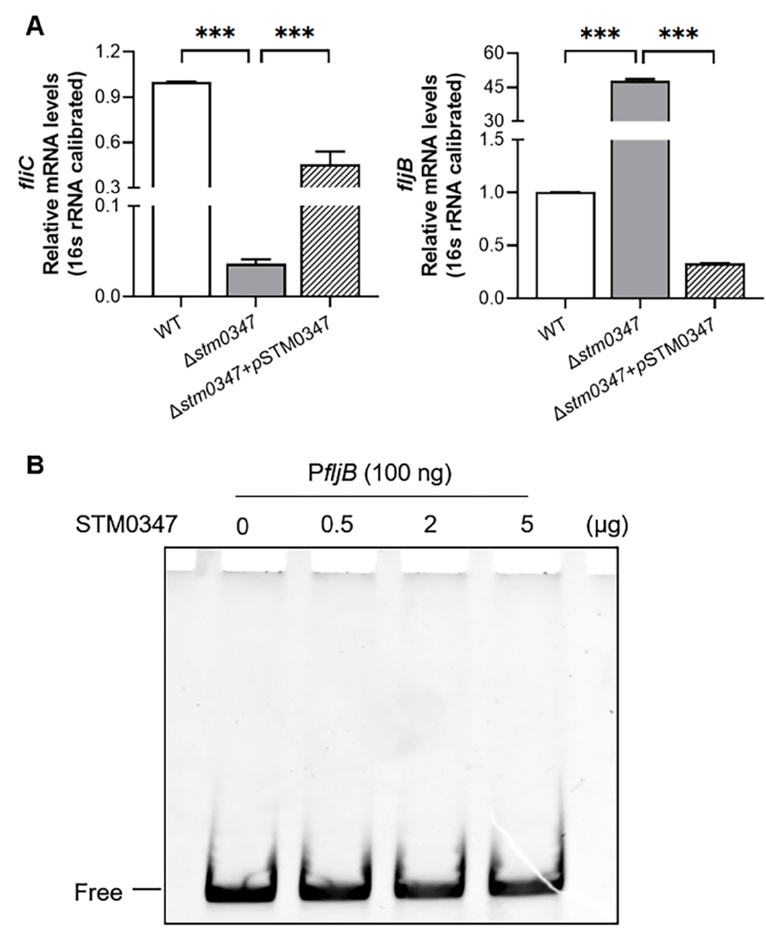
Figure 4. Transcriptional regulatory effect of fliC and fljB by STM0347. ( A ) Relative mRNA levels of fliC and fljB in WT, Δ stm0347 , and Δ stm0347 complemented with an STM0347-expressing plasmid induced with 0.001% arabinose. Expression levels are calibrated with 16 s rRNA. Results are presented as mean ± SD. Asterisks indicate significant differences (*** p < 0.001). ( B ) EMSA experiments denied the direct regulation of STM0347 on fljB promoter. Different amounts of purified STM0347 (ranging from 0 to 5 μ g) were incubated with fljB promoter prior to electrophoretic separation. ‘Free’ indicates free DNA.